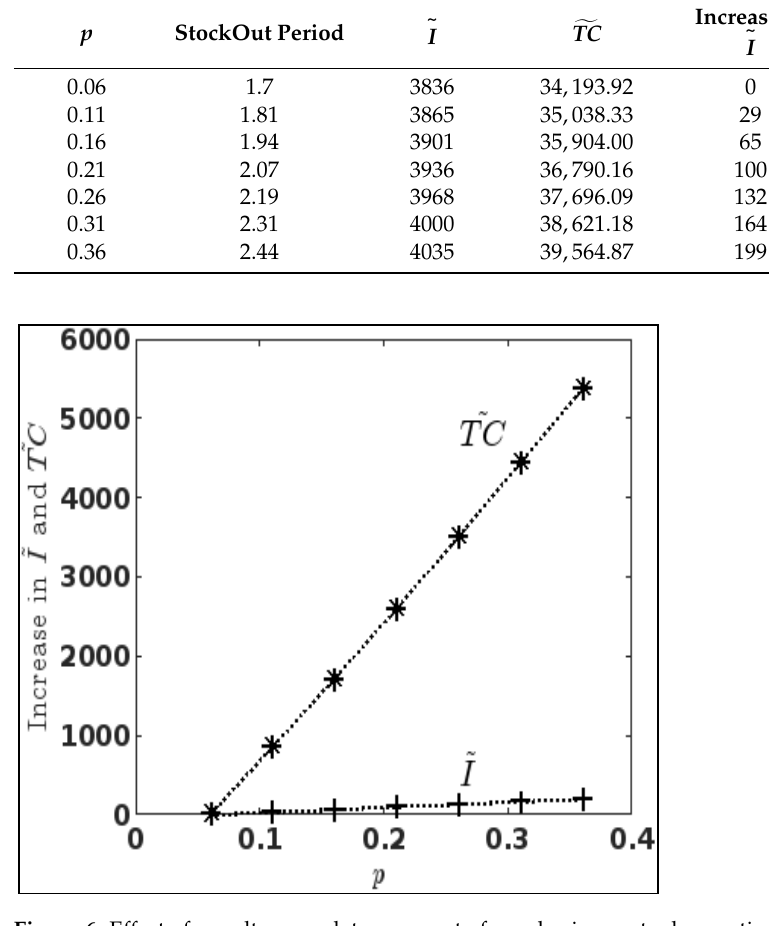
Figure 6. Effect of penalty upon late payment of purchasing cost when optimizing the total cost and ordering quantity. ordering